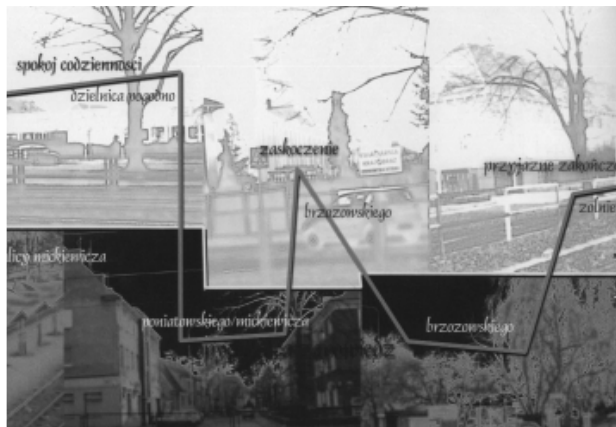
Fig. 4: M. Wysocka, Graph of Feelings on the Time Axis on the Way from the House to College, http://architektura.ps.pl/PDF%20-%20przestrzen%20i%20FORMA%20nr1%202005%20- %2011.10.05/13%20Satkiewicz-Parczewska%20Aleksandra.pdf, p. 131, retrieved: 23. 11.